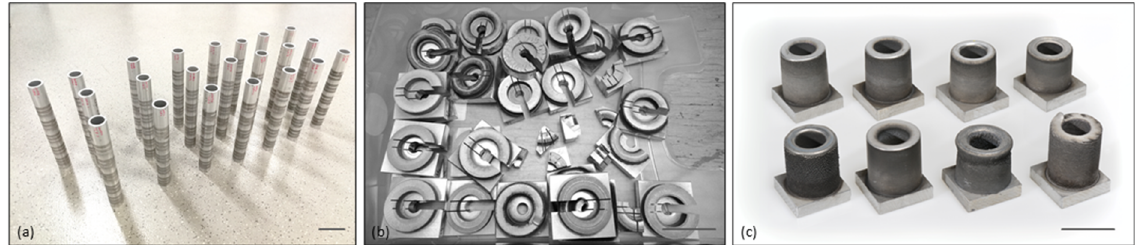
Figure 5 . Exterior views of specimens of ( a ) single tracks, ( b ) 3D-parts with about 5 mm height and used for hardness tests, and ( c ) 3D-parts with about 50 mm height and used for tensile tests. The black bars indicate a length of 50 mm. Table 1. Parameter sets of laser power P , travel speed v , nozzle’s own shielding gas flow rate V s , additional shielding gas flow rate V ad . and shielding and exhausting measures for fabricating 3D-